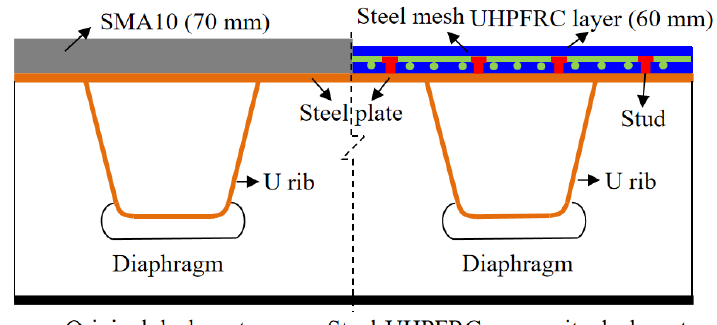
Figure 1. Two different bridge deck